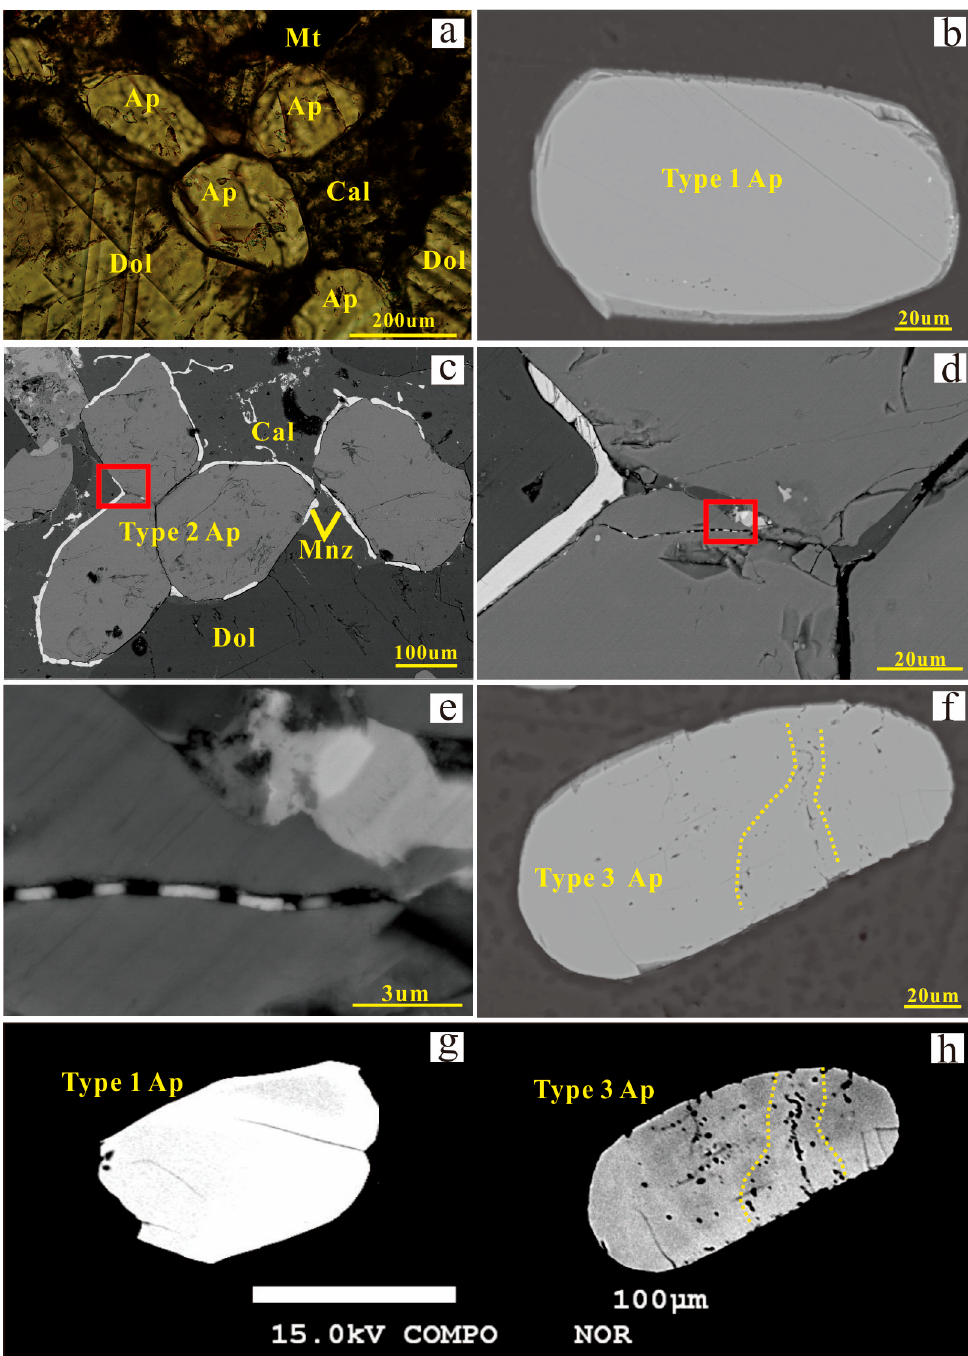
Figure 4. Representative photomicrographs of three types of apatite grains. ( a ) Apatite intergrown with dolomites (cross-polarized light). ( b ) BSE image of Type 1 apatite showing no obvious signs of alteration. ( c ) BSE image of Type 2 apatite. ( d ) Magnification of the box area in ( c ), showing details of intergranular boundary with monazite. ( e ) Magnification of the box area in ( d ), showing generation of monazite along the apatite internal fracture. ( f ) BSE image of Type 3 apatite, showing fluid veinlets crosscutting the grain. ( g ) CL image of Type 1 apatite showing a light and smooth surface. ( h ) CL image of Type 3 apatite, showing a dark surface with veinlets. Abbreviations: Mnz-monazite; others are the same as above.